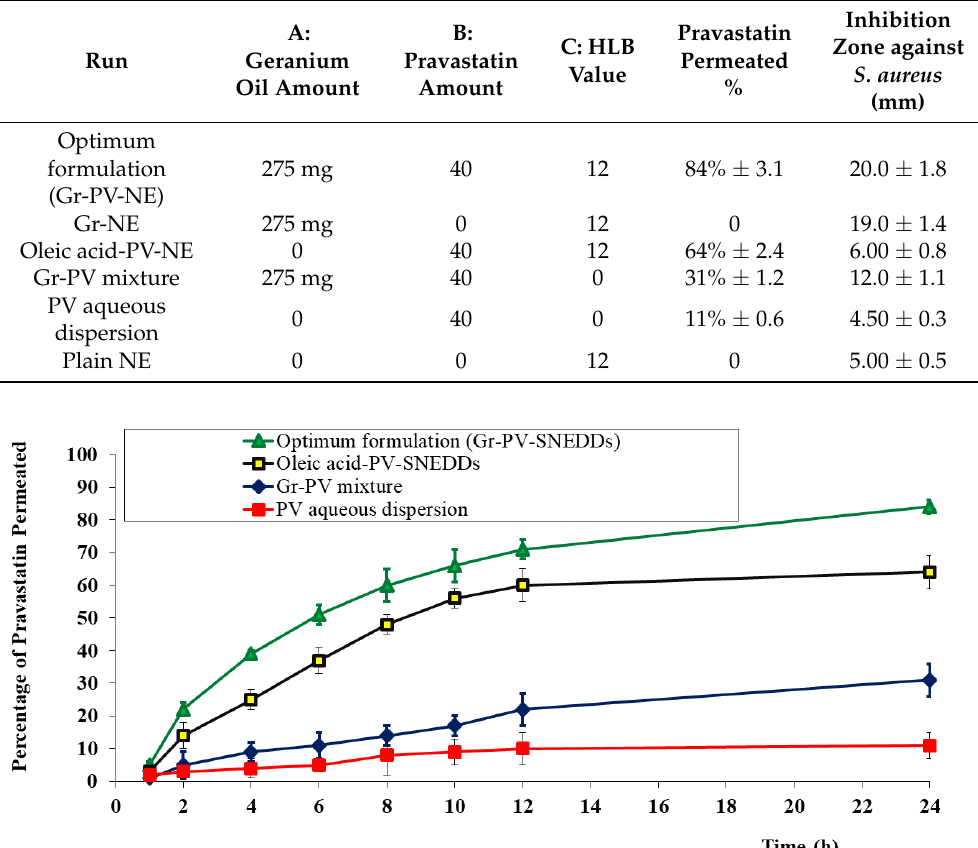
Table 4. Inhibition zones against S. aureus and percentage PV permeated for varying formulations.